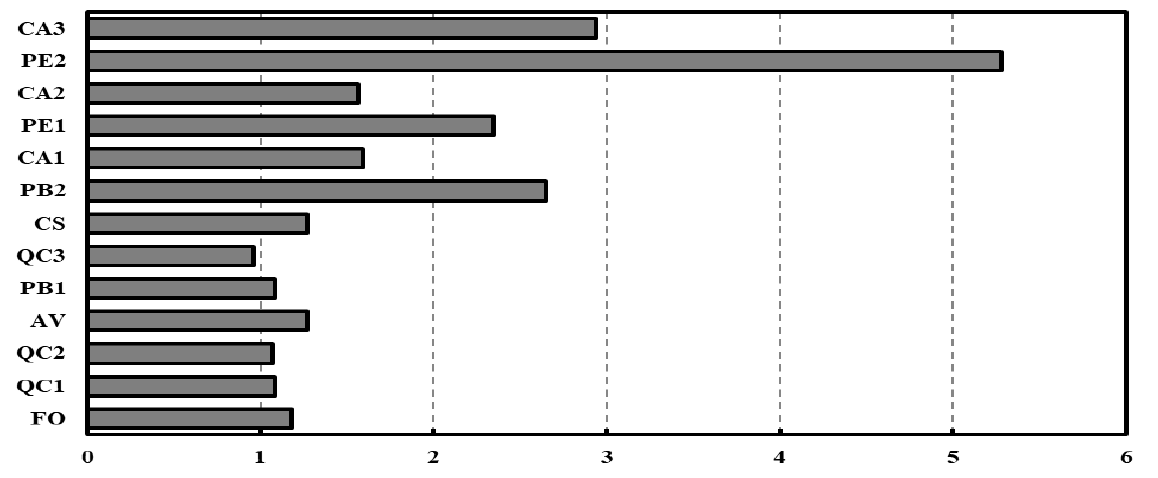
gure 2. Mean throughfall (TF) sensitivity coefficients for the measurement sites. See Table 1 for the tree species represented by